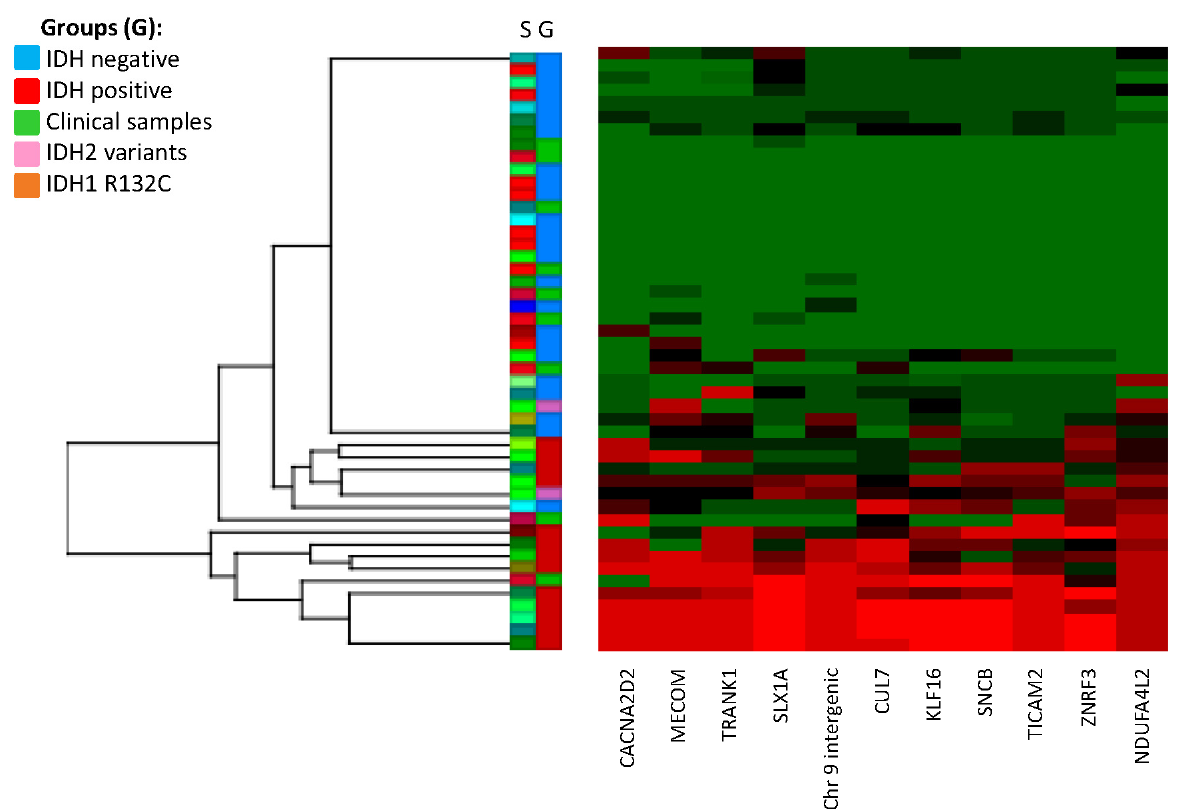
Figure 2. Hierarchical clustering of discovery and replication cohorts. The top 11 CG sites (column) that were differentially methylated (epi-signature) in IDH-positive versus IDH-negative group. Row; S: individual samples. G: group (blue: IDH-negative, red: IDH-positive, pink: IDH2 variants by NGS, orange: IDH1 variant by NGS, green: replication cohort samples).